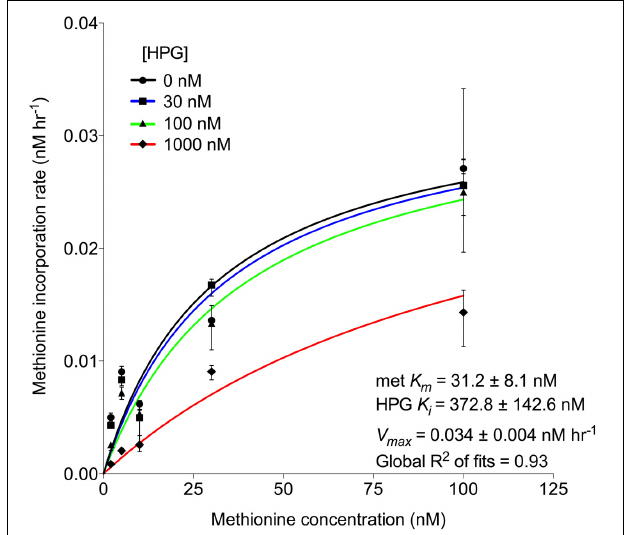
FIGURE 2 | Michaelis-Menten kinetics ( ± 95% confidence intervals) displaying HPG competitive inhibition of methionine, i.e., unchanging V max and decreasing K m values of methionine uptake with increasing HPG concentration, where HPG acts as an inhibitor. Included are the half-saturation constants for methionine and HPG. Each point ( ± 95% confidence intervals) was calculated from triplicate 35 S-methionine incorporation samples of Scripps Pier microbial communities at 5 concentrations (2, 5, 10, 30, and 100nM) in the presence of 0, 30, 100, and 1000nM